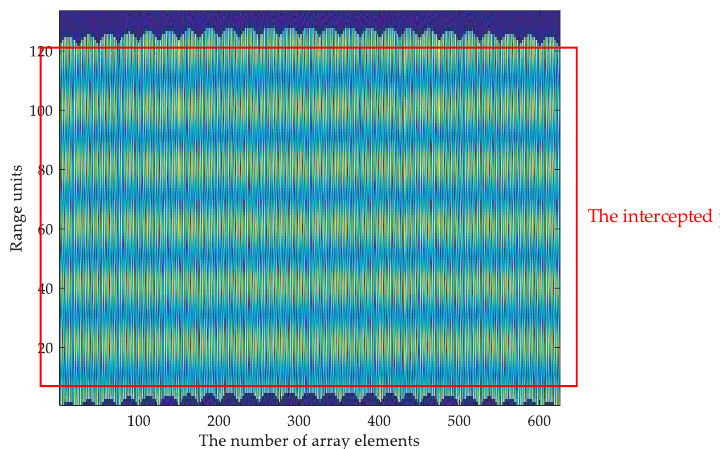
Figure 14. Schematic diagram of the intercepted part after interpolation.